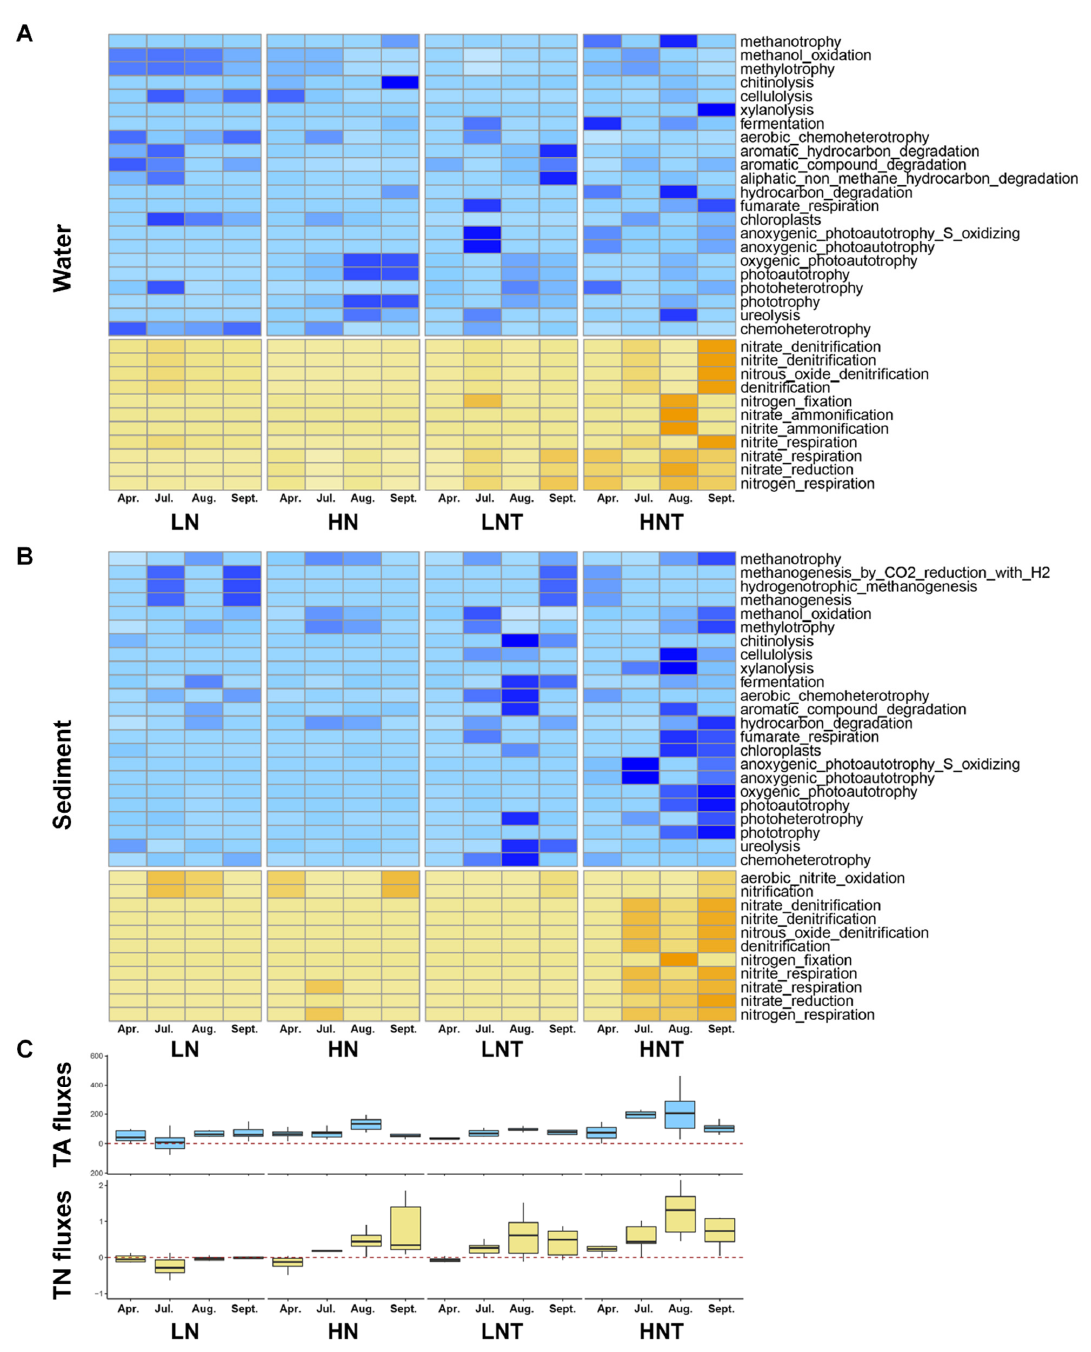
Figure 1. The relative abundances of C and N functional genes in the collected samples, as well as the corresponding fluxes of total alkalinity (TA) and total nitrogen (TN), changes between April and October in 12 mesocosms warmed by 4.5 ◦ C above ambient and 12 unheated mesocosms. The relative abundance was calculated based on the percentage of functional gene to 16S rRNA gene of bacteria. ( A ) The water samples. ( B ) The sediment samples. ( C ) Fluxes of total alkalinity (TA) and total nitrogen (TN). The color shades in A and B indicate the amount of relative abundance, with dark colors indicating high and light colors indicating low. Blue for C functional genes and yellow for N functional